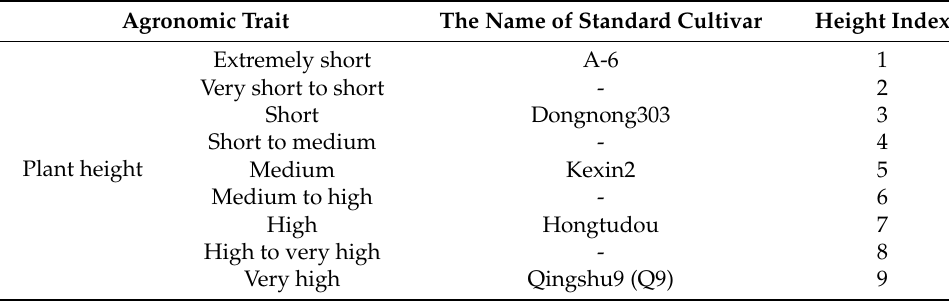
Table 1. Plant height index standard in potato